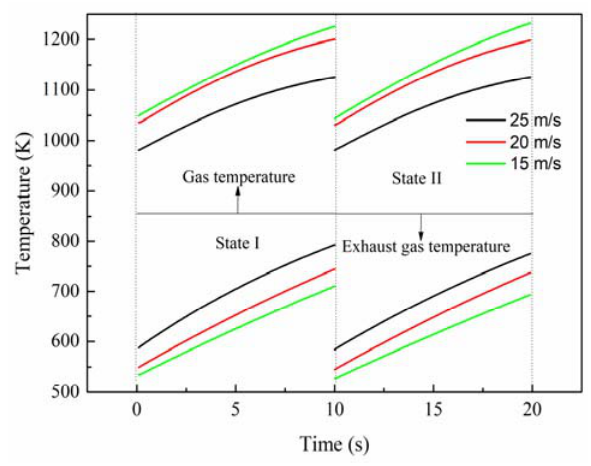
Figure 1. The gas temperature at different inlet velocities; C in , ch4 = 2%.